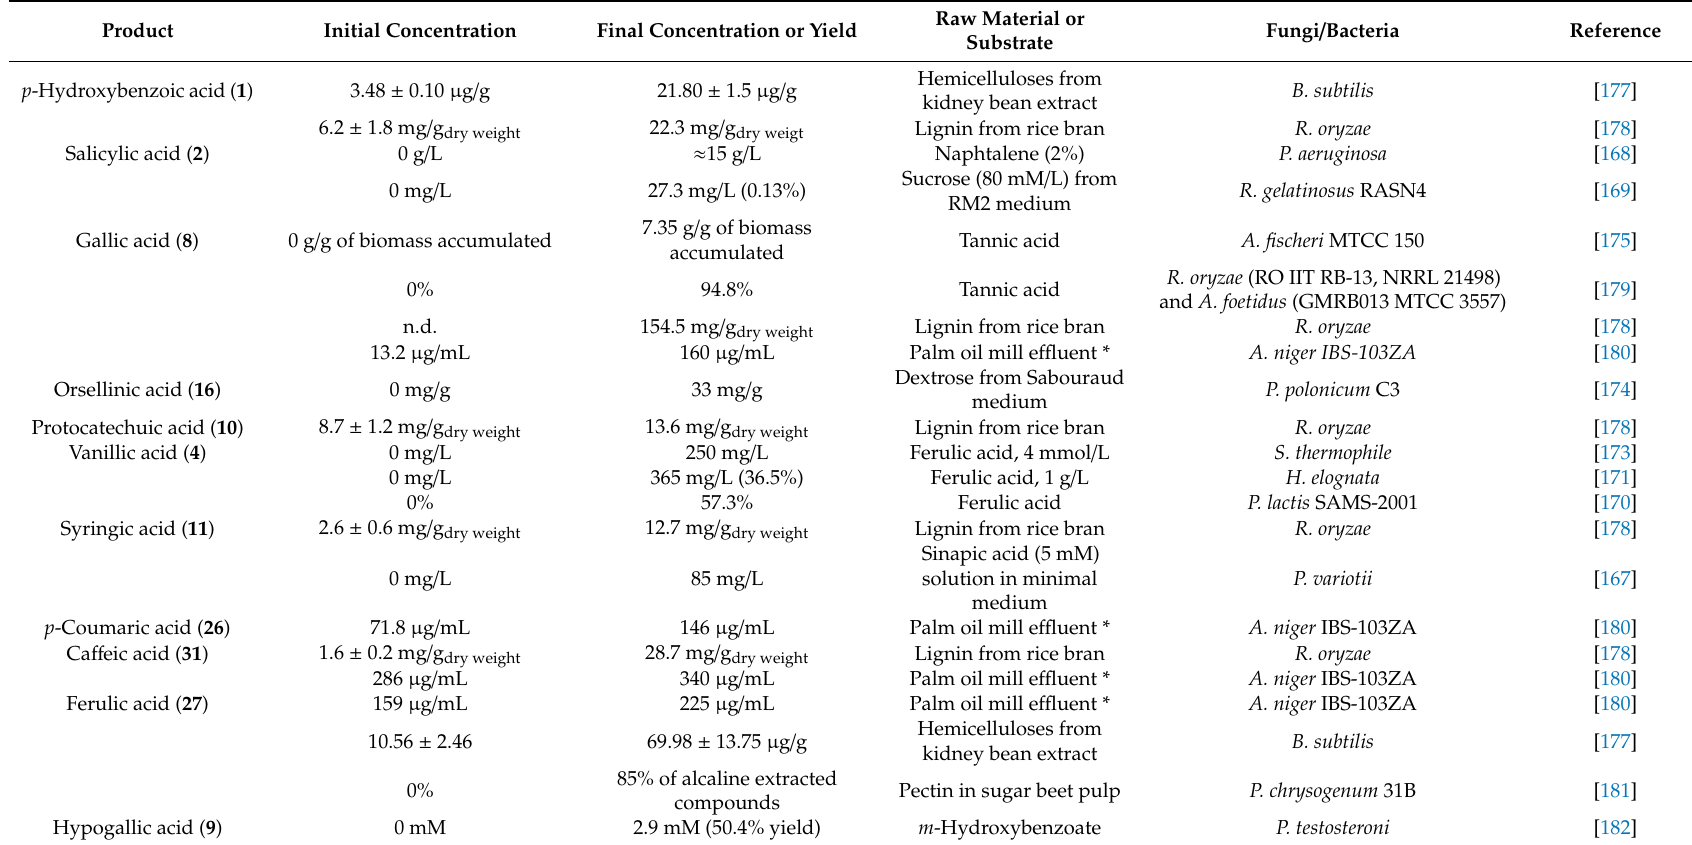
Table 5. The production of phenolic acids produced through biotransformation or fermentation using non-modified